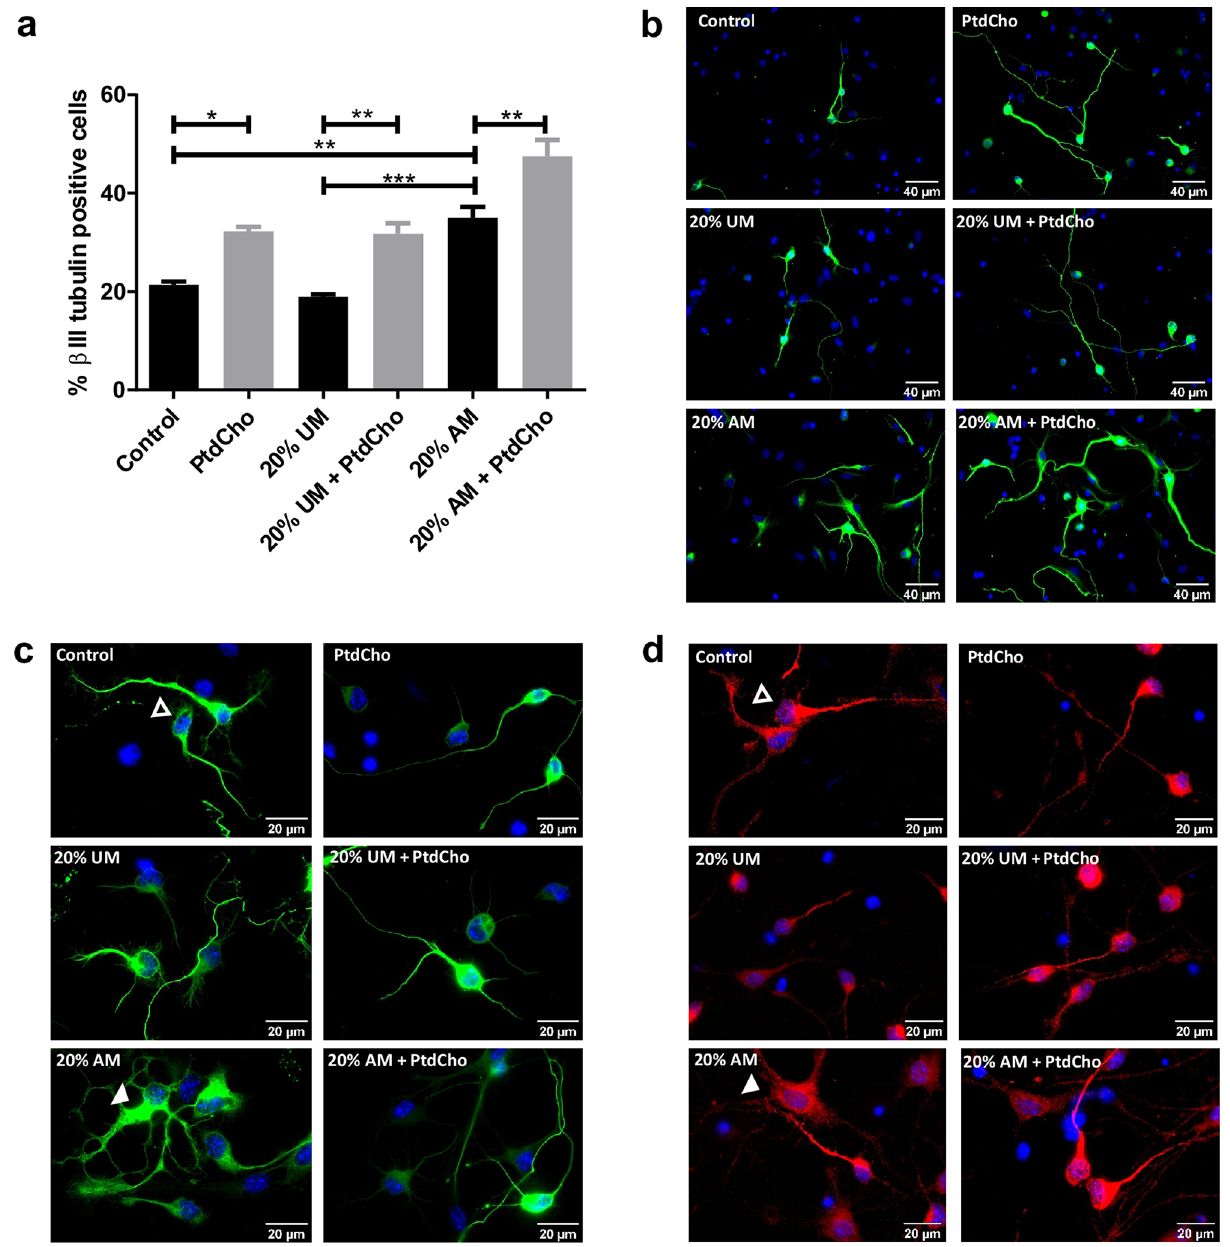
Figure 2. NSCs differentiation is affected by inflammation and restored by PtdCho. ( a ) Percentage of β-III tubulin positive cells analysed by immunocytochemistry coupled to fluorescence microscopy of NSCs exposed to 20% V/V of AM and UM in the presence or in the absence of PtdCho (50 μM) during 3 days. Graph represents the percentage of neuronal differentiation measured in five independent experiments. Data were presented as mean ± SEM. ***p < 0.001; **p < 0.01; *p < 0.05. ( b ) Representative images (× 40) of the immunofluorescence assays with the neuronal marker (β-III tubulin, green) nuclei (DAPI, blue). Scale bars: 40 μm. Representative images of neurons morphology under the indicated condition (× 100) βIII-tubulin (green) ( c ) or MAP2 (red) ( d ) Open arrow indicates normal neuron and white arrow indicates dystrophic neuron. Scale bars: 20